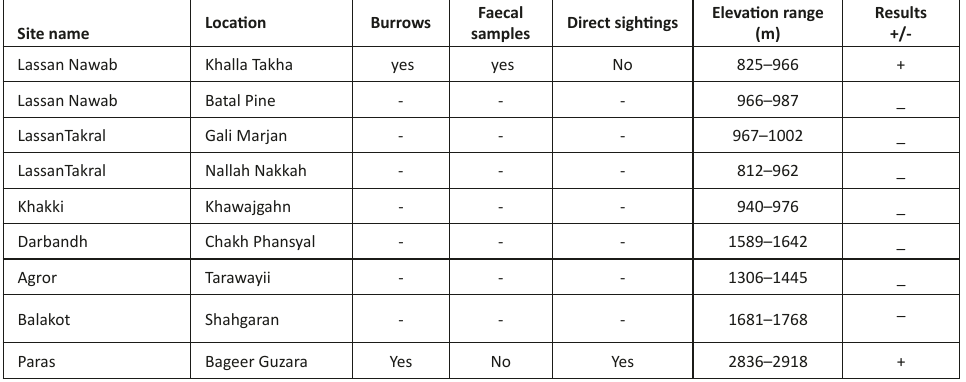
Table 2. Details of direct and indirect signs of the Indian Pangolin Manis crassicaudata recorded at selected sampling sites of Mansehra District. Site